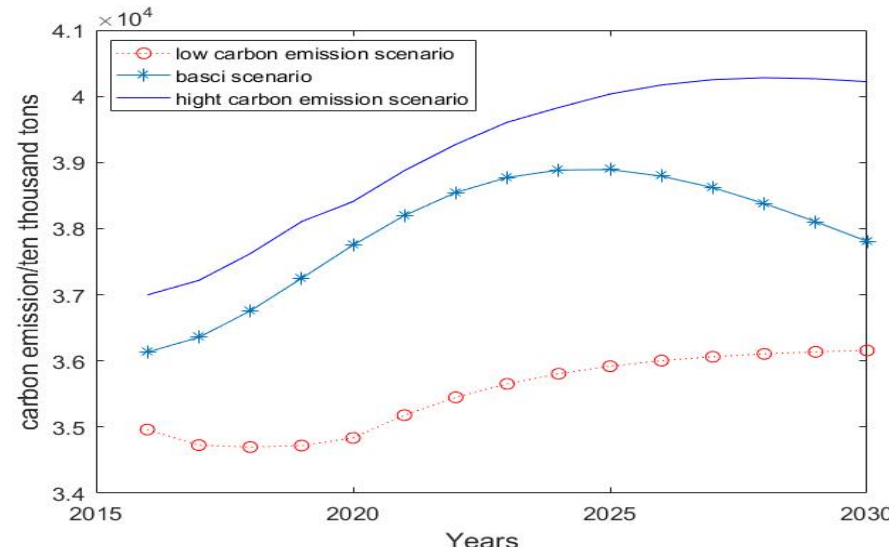
Figure 5. The results of the CO 2 emission predicted by IPSO-BP neural network model in the Beijing-Tianjin-Hebei region at three different scenarios during 2015–2030. Figure source: Application of the well trained IPSO ‐ BP neural network model to forecast the